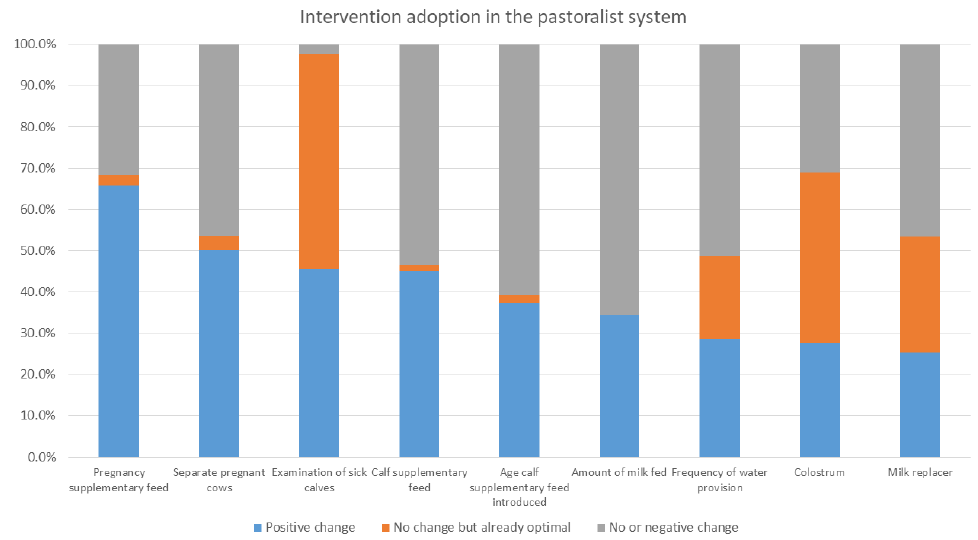
Figure 4. The proportion of enrolled pastoralist households with baseline and final evaluation data with either (a) no change in intervention area practices during the study period but were already optimal at the start of the study, (b) positive change, or (c) no or negative change in intervention areas. N.B. Navel dipping and calf pens were not selected interventions for the pastoral system.